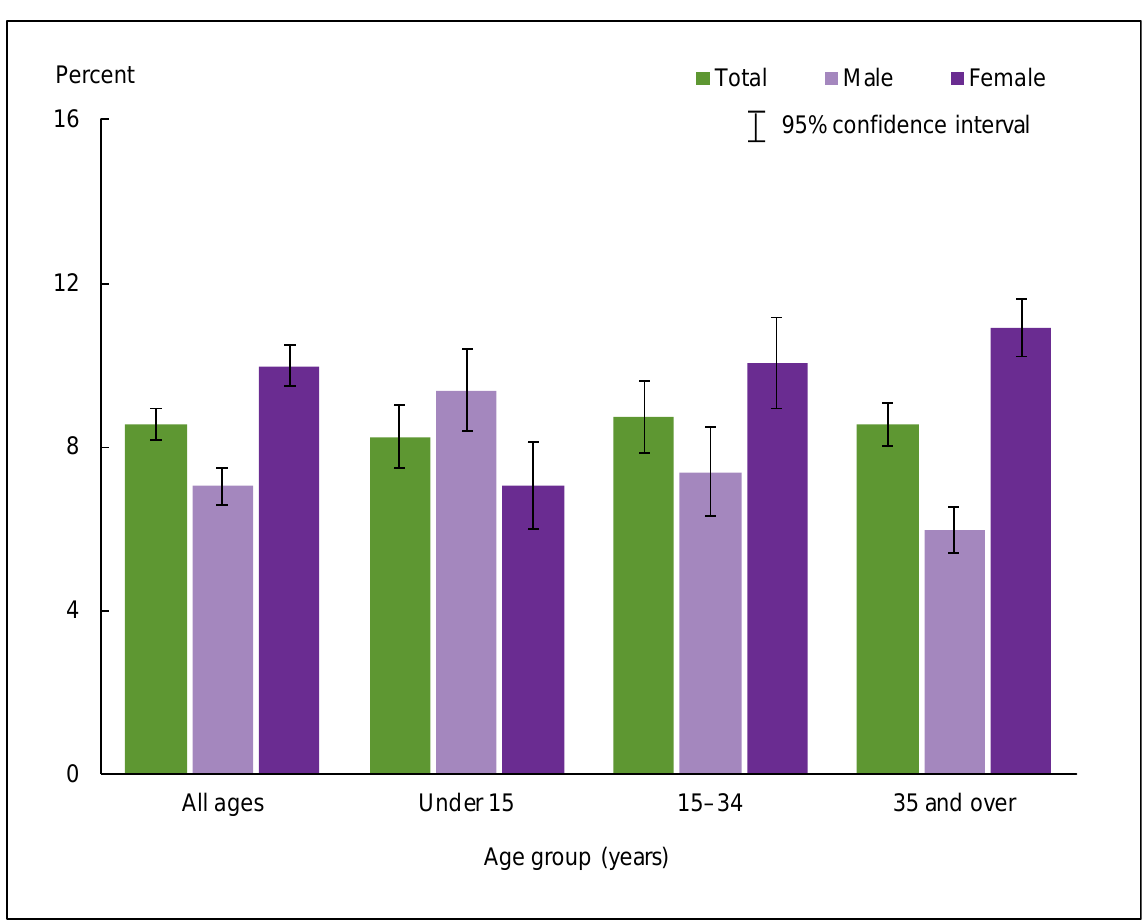
Figure 15.5. Prevalence of current asthma among persons of all ages, by age group and sex: United States,